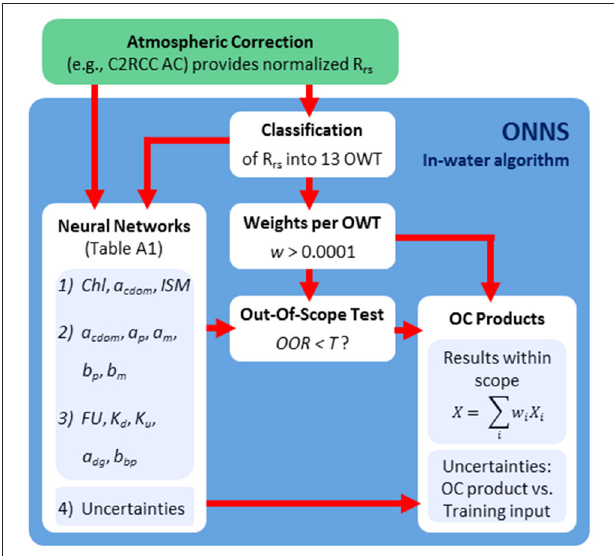
FIGURE 1 | Flowchart of the OLCI Neural Network Swarm in-water ocean color processor.